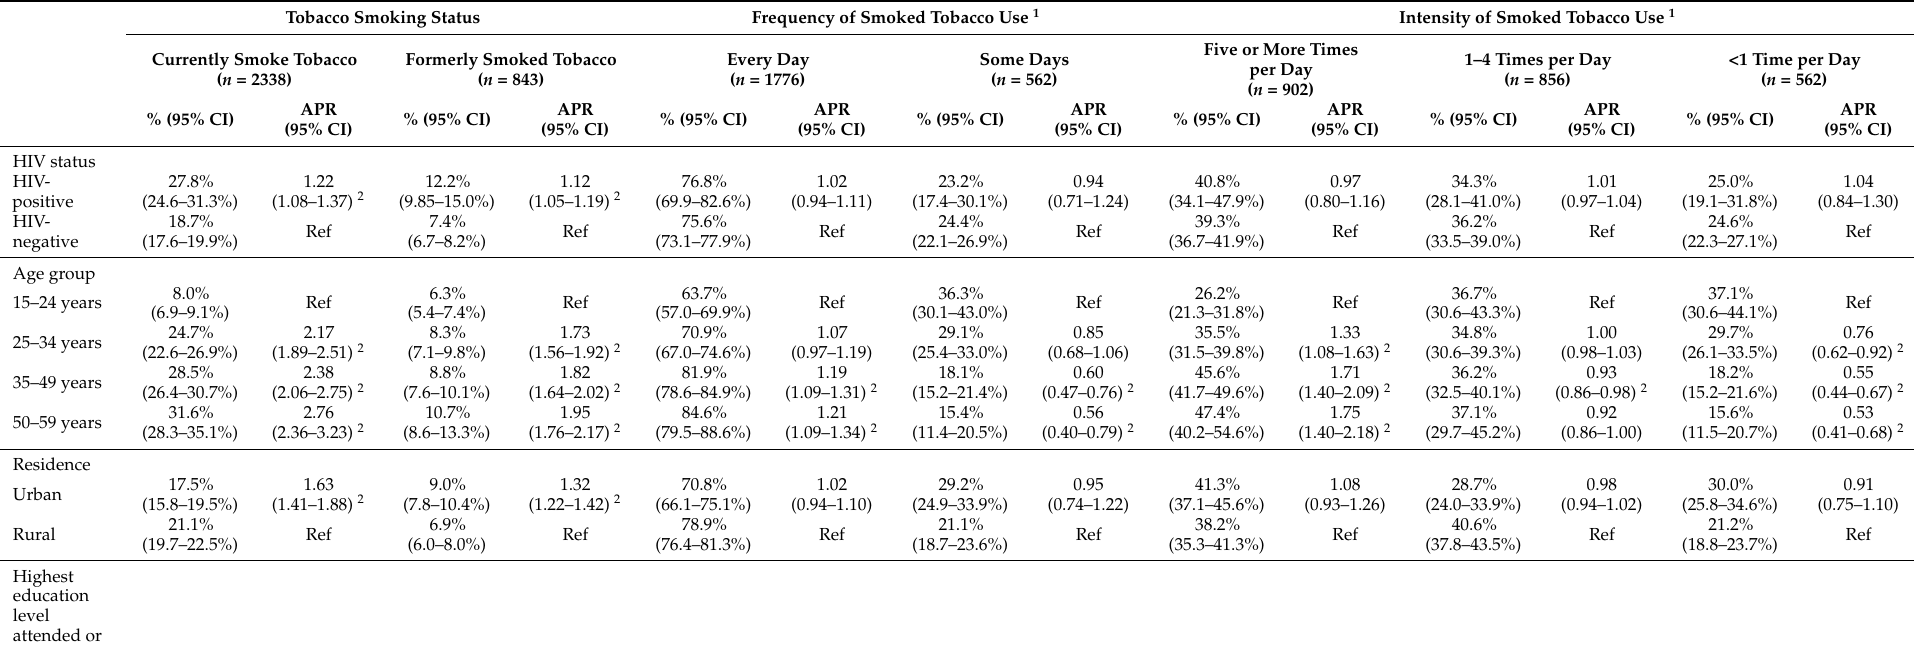
Table 4. Prevalence and adjusted prevalence ratios (APRs) for HIV status and selected characteristics with tobacco smoking status, frequency of smoked tobacco use, and intensity of smoked tobacco use among men—2018 DHS,